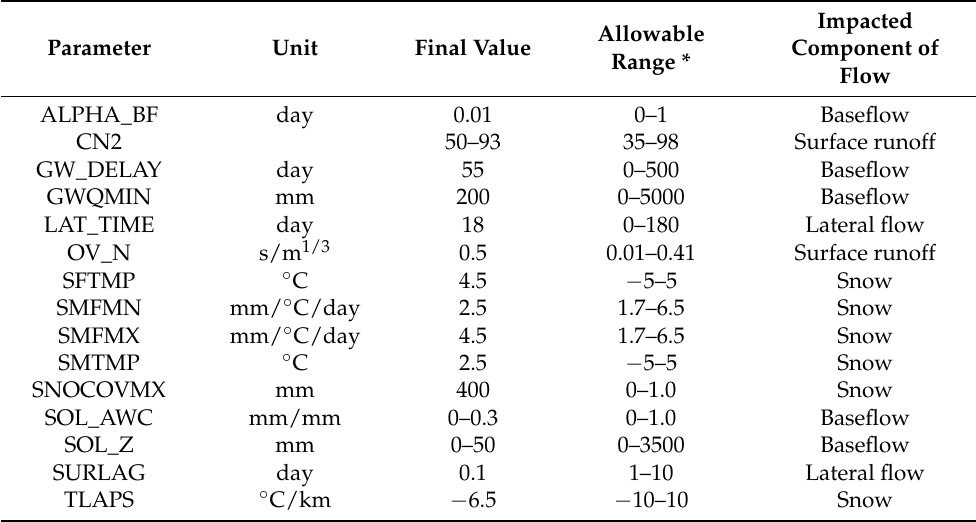
Table 2. Selected SWAT parameters and their calibrated values.